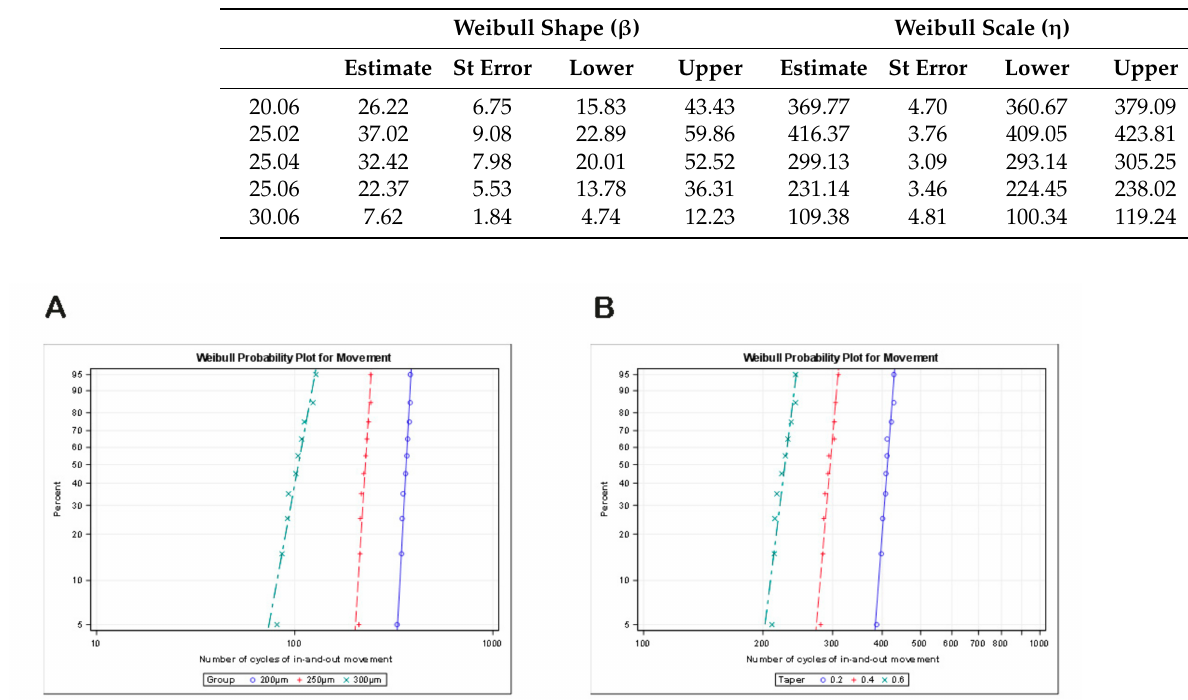
Table 6. The Weibull statistics of the number of cycles of in-and-out movements for the apical diameter and taper study groups.